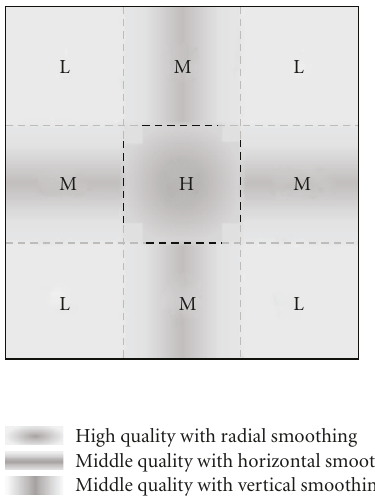
High quality with radial smoothing Middle quality with horizontal smoothing Middle quality with vertical smoothing Low quality with no smoothing Figure 4: Method I as applied to the tessellation